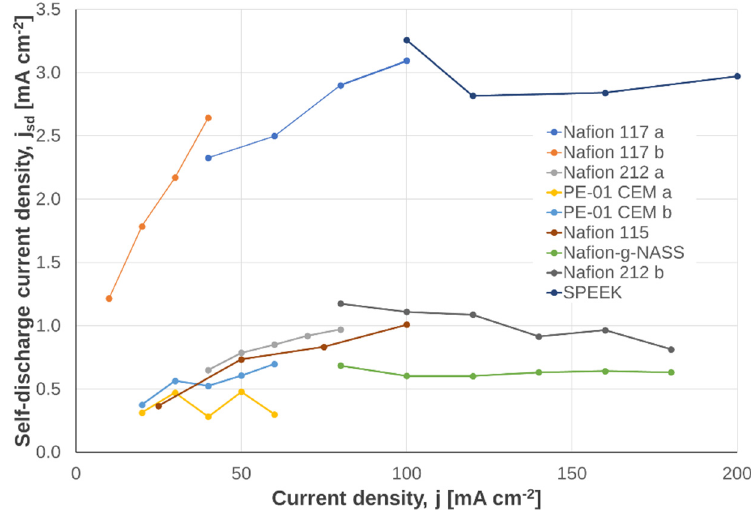
Figure 7. Self-discharge current densities of vanadium flow cells with a range of membrane types, derived from the literature η Q values under constant current cycling conditions. Note that electrolyte compositions varied and electrolyte temperatures were not given. The information sources were: Nafion 117 a [45], Nafion 117 b [46], Nafion 212 a [47], PE-01 CEM a [48], PE-01 CEM b [49], Nafion 115 [50], Nafion 212 b and Nafion-g-NASS [51], SPEEK [52].